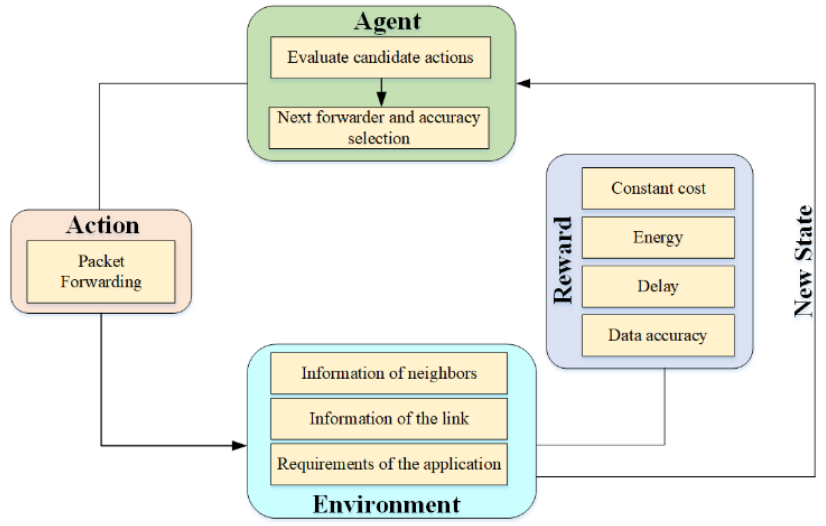
Figure 4. Framework of adaptive data transmission model based on reinforcement learning.